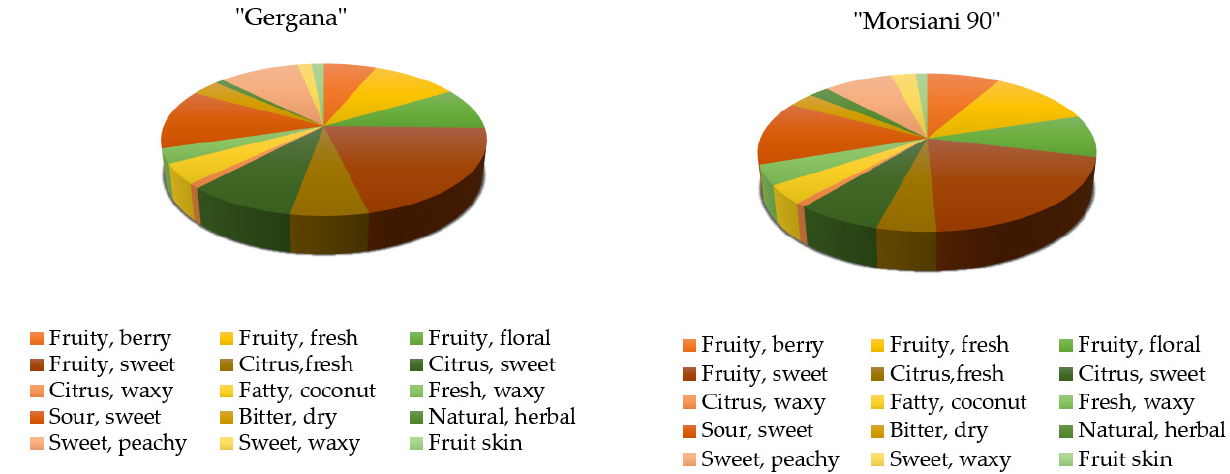
Figure 2. Flavor component distribution (%) in nectarine varieties.